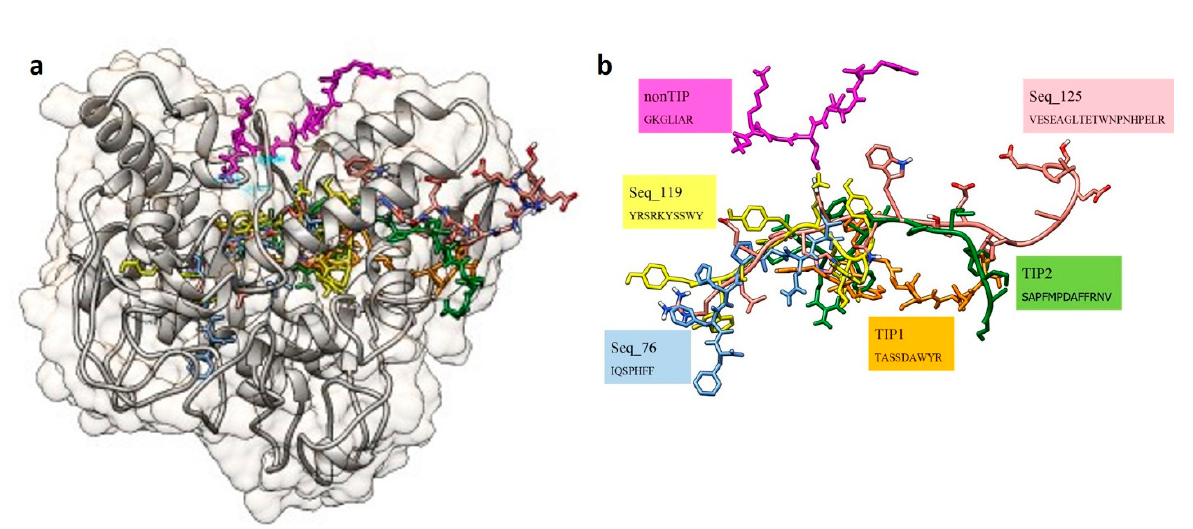
Figure 3. Comparative molecular docking of three known tyrosinase inhibitory peptides (Seq_76, Seq_119, and Seq_125) with those of the non-tyrosinase inhibitory peptide (non-TIP) and the putative tyrosinase inhibitory peptides (TIP1 and TIP2) on the crystal structure of mushroom tyrosinase (PDB ID: 2Y9X) shown with ( a ) and without ( b ) the enzyme structure. Structure of the mushroom tyrosinase is shaded in gray and the peptides are labeled with different colors.